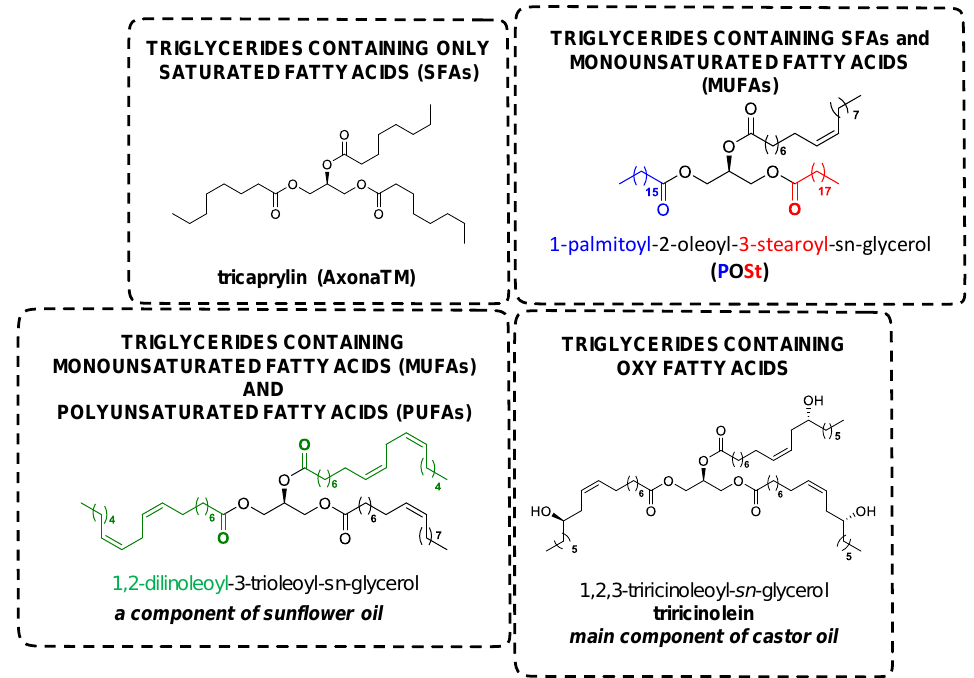
Figure 14. Some examples of the structural diversity of triglycerides.